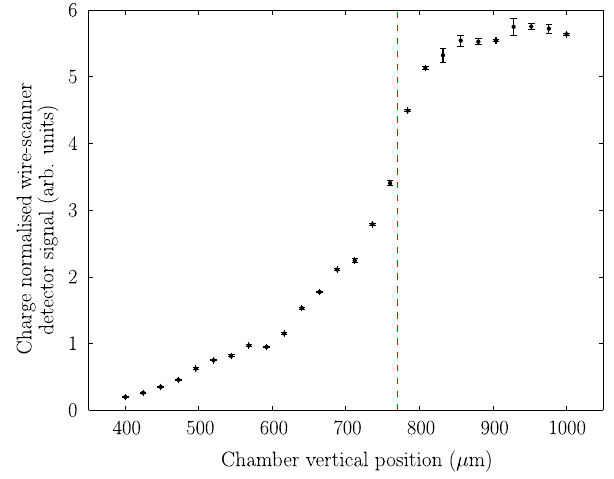
FIG. 13. Measured brehmstraahlung radiation as a function of vertical chamber position with the OTR screen at the laser focus reference position. The red dashed line shows the chosen align-